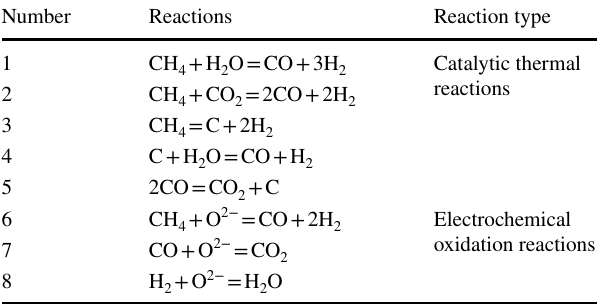
Table 1 Methane reactions in SOFC anode